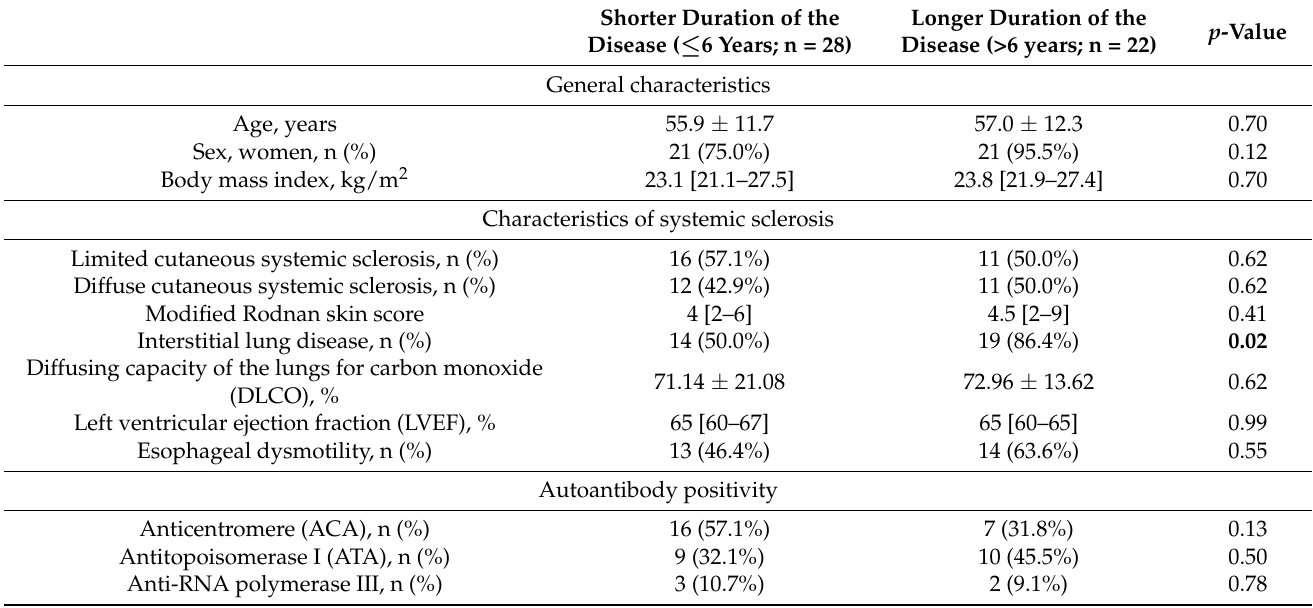
Figure 2. The serum concentration of lipopolysaccharides (LPS) ( A ) and claudin-3 (CLDN3) ( B ) in patients’ subgroups with different durations of systemic sclerosis (SSc); Q1 – the first quartile; Q3 – the third quartile; Min – the lowest value; Max – the highest value (* p < 0.05). Table 2. The characteristics of the patients with shorter (≤6 years) and longer (>6 years) durations of systemic sclerosis.